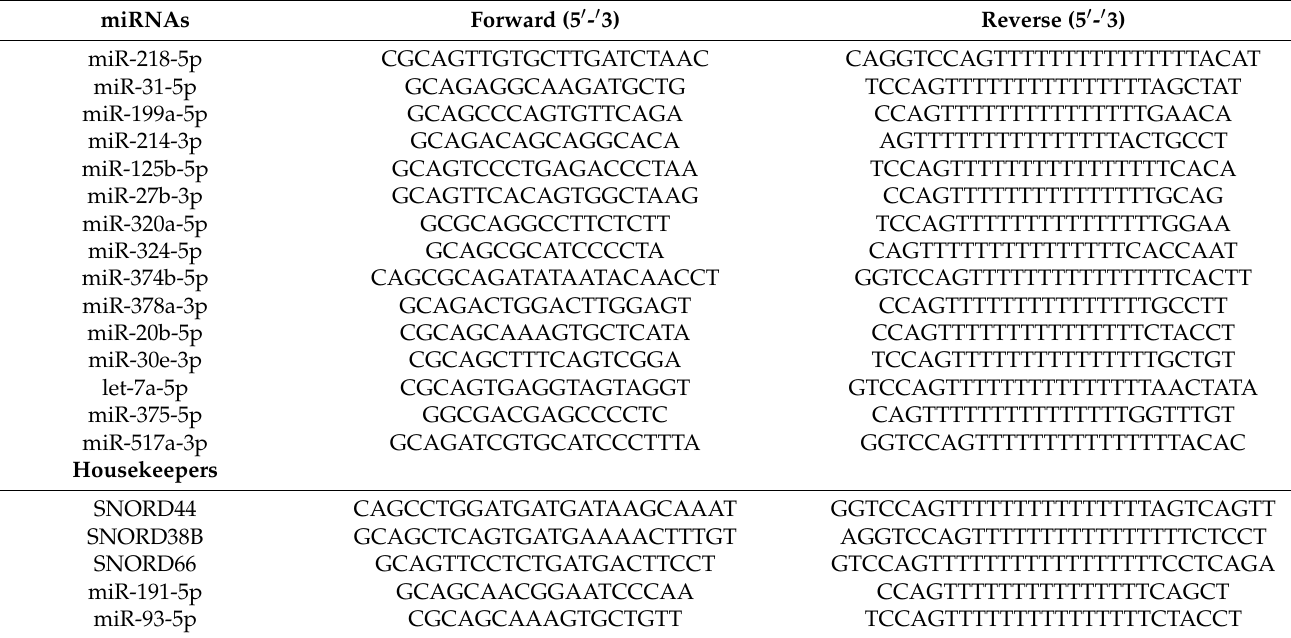
Table 2. List of primers used for qPCR validation of miRNAs’ expressions.